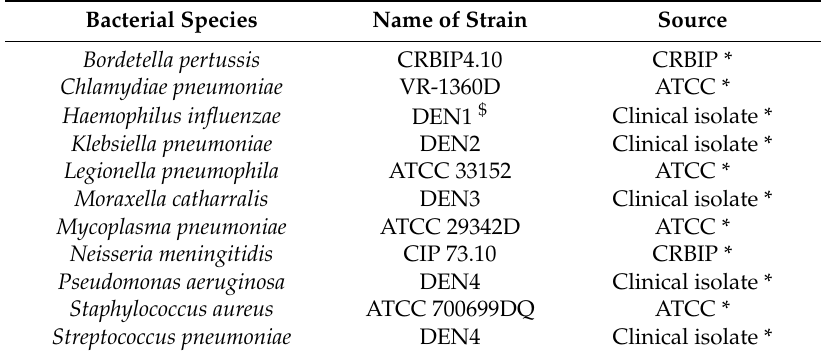
Table 1. Pathogen bacterial strains used to evaluate the specificity of the designed probes from hypervariable rDNA regions in their genomes.